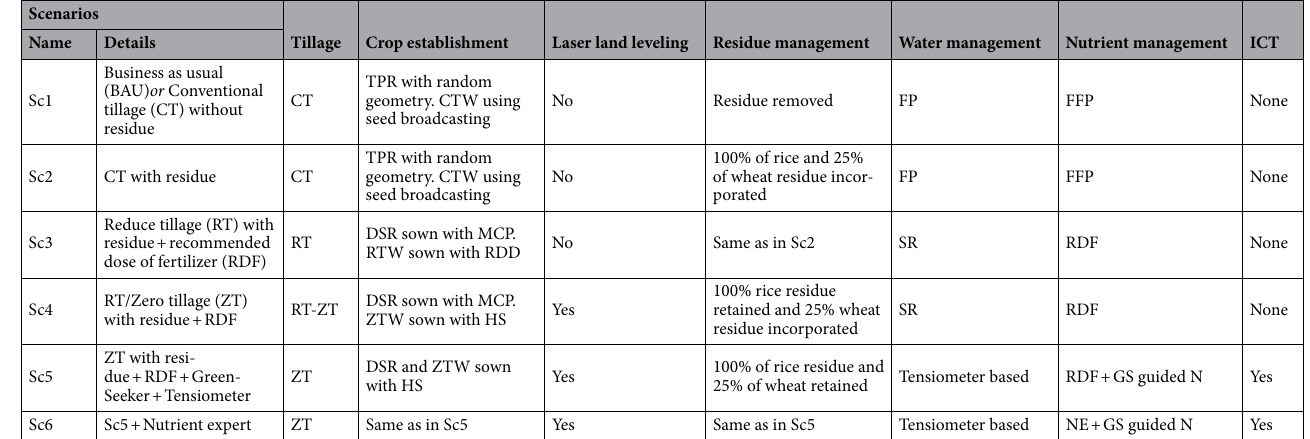
Table 4. Scenario notations and description of management protocols under different scenarios in rice– wheat (RW) system. CT conventional tillage, RT reduced tillage, ZT zero tillage, TPR transplanted rice, CTW